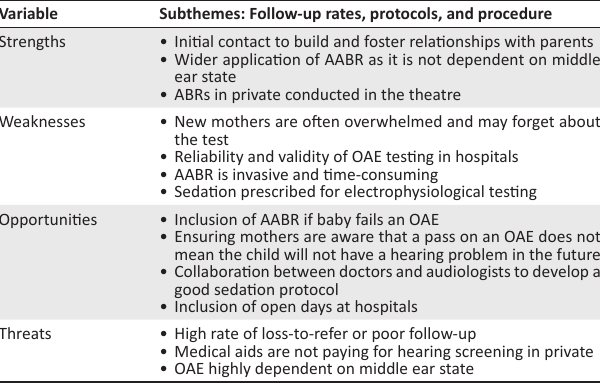
TABLE 4: Strengths, weaknesses, opportunities, and threats for theme 4: Evaluating protocols and procedures for screening and managing